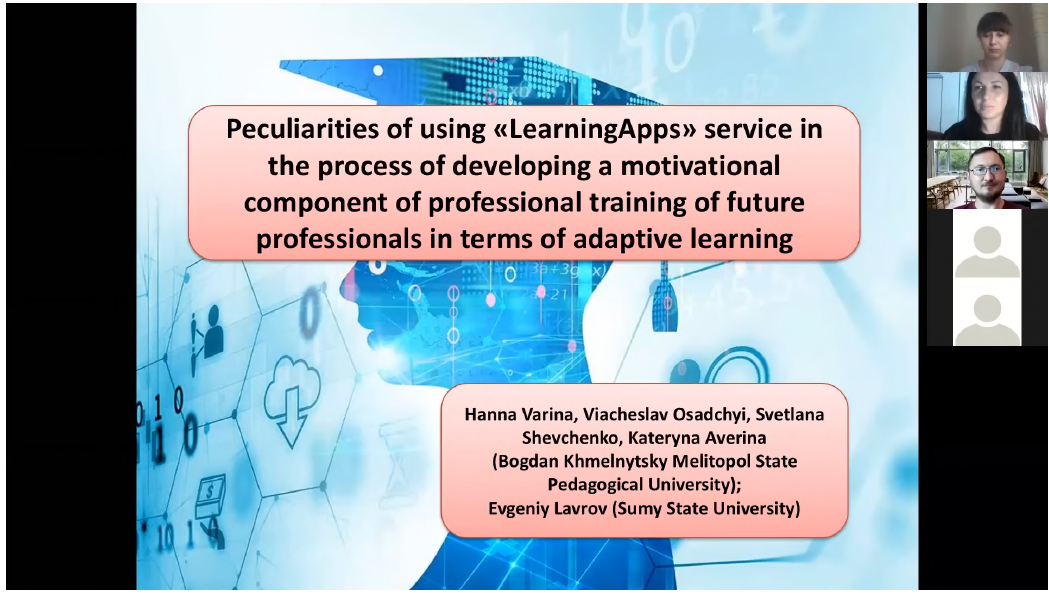
Figure 17: Presentation of paper